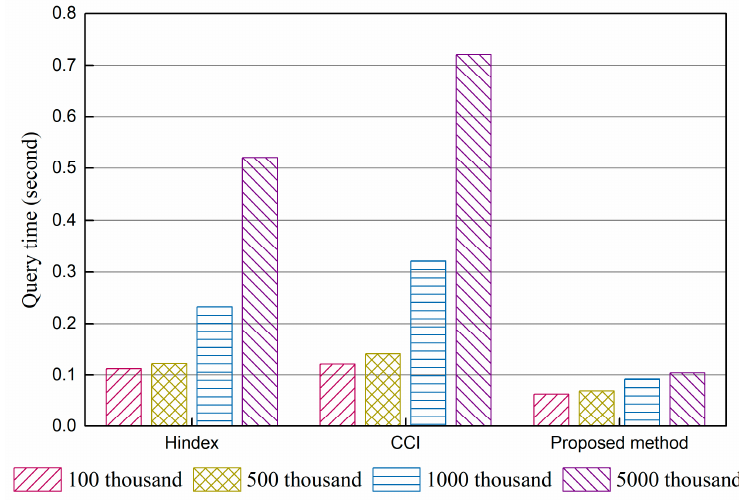
Figure 6. Effect of query conditions.